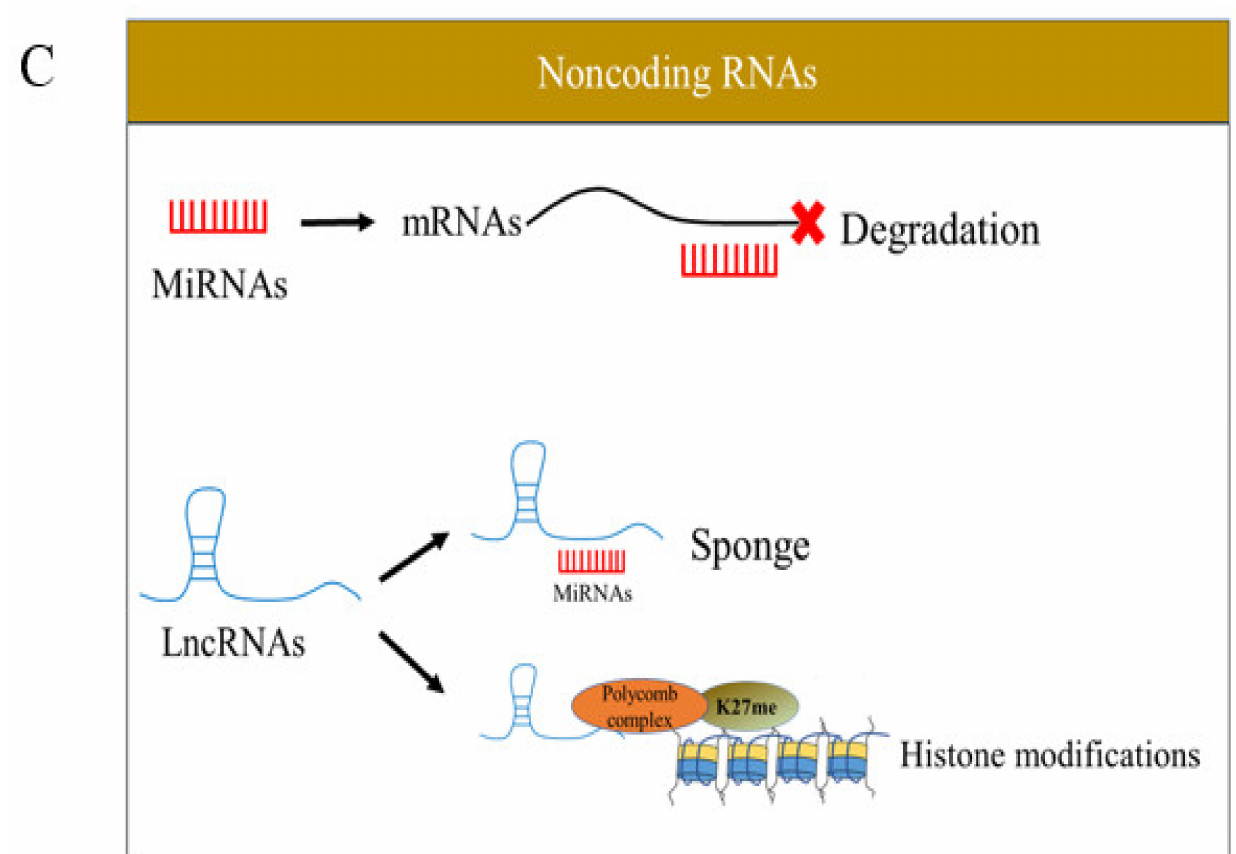
Figure 1. Schematic presentations of three major epigenetic regulations. ( A ) DNA (de)methylation; ( B ) histone modifications; and ( C ) noncoding RNAs. Denote: 5 mCpG: A methyl cytosine followed by guanine along the 5’ to 3’ direction, DNMT: DNA methyltransferases, TET: Ten-Eleven Translocation, CBP: CREB-binding protein, HDACs: Histone deacetylases, BRDs: Bromodomain-containing proteins, Ac: Acetylation, miRNAs: MicroRNAs, and LncRNAs: Long noncoding